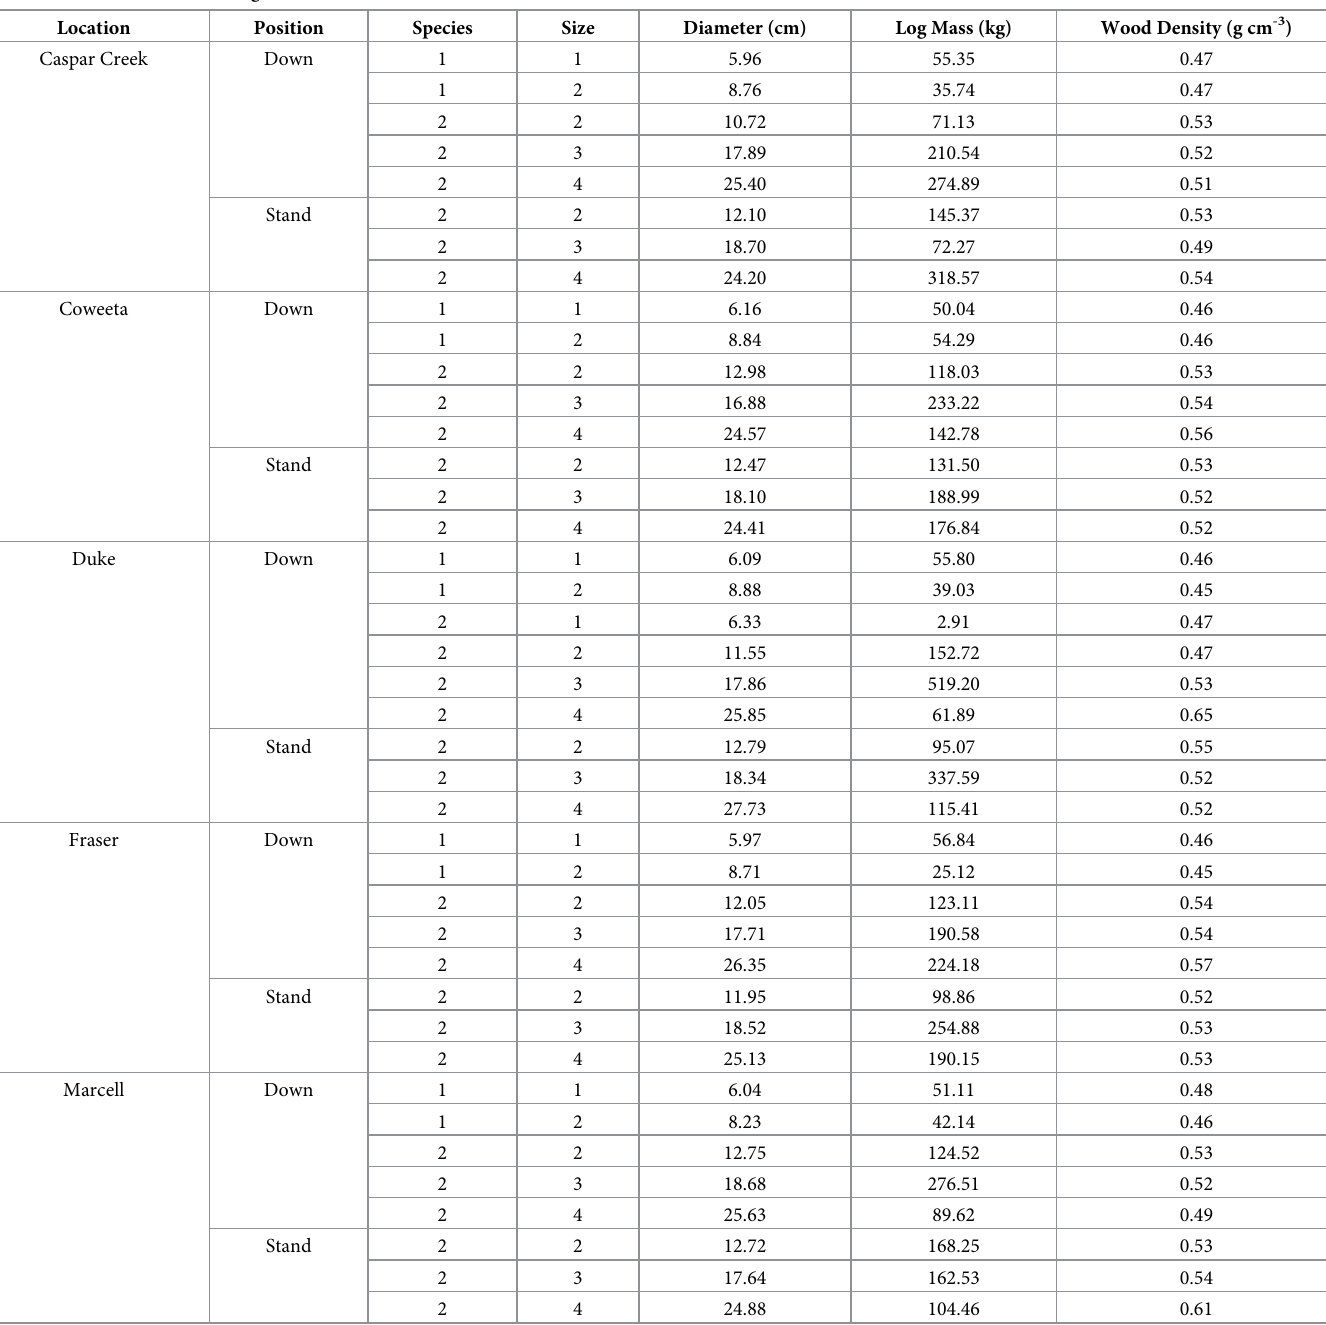
Table 2. Parameters of FACE logs used to calibrate and validate the model � . Location Caspar